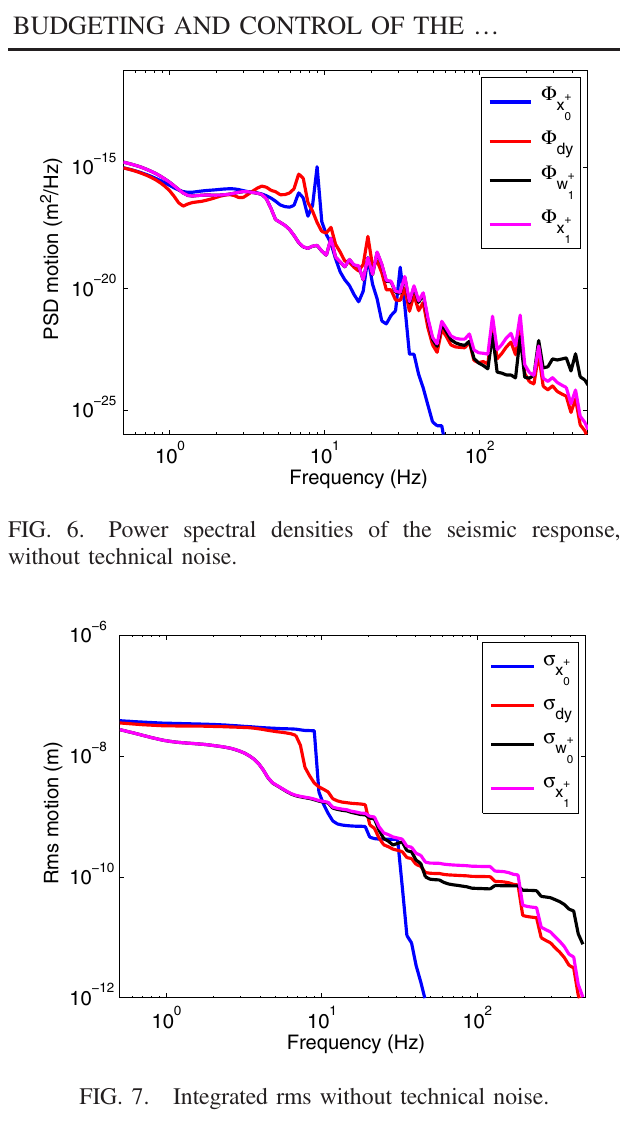
FIG. 8. Integrated rms for k